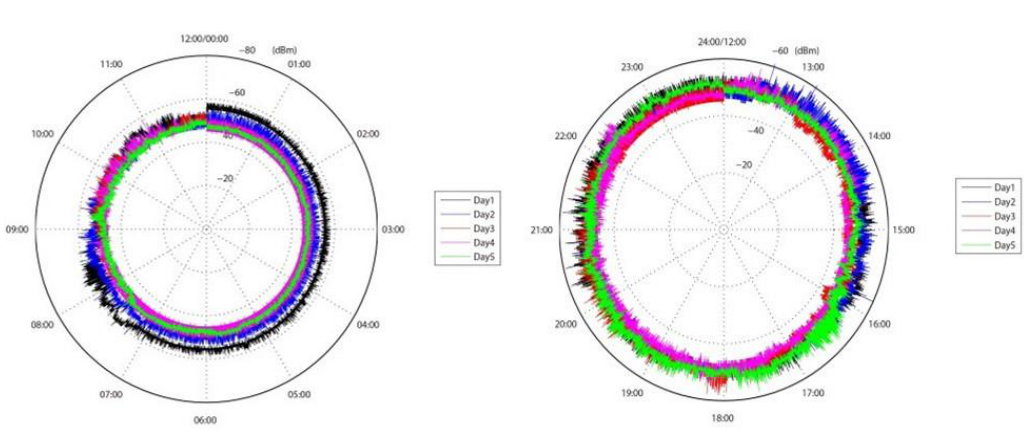
Figure 3. The polar coordinates diagram for statistical results of the Wi-Fi signal in the five consecutive days.